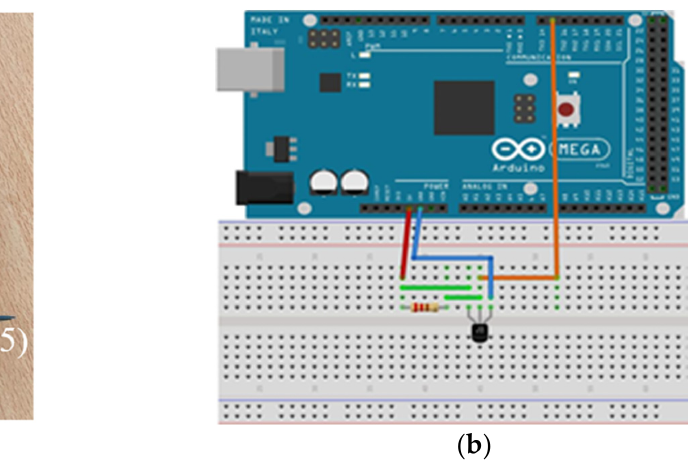
Figure 4. HEAT DS18B20: ( a ) Indoor module and wire connections of one DS18B20 sensor with the Arduino Mega ( b ).